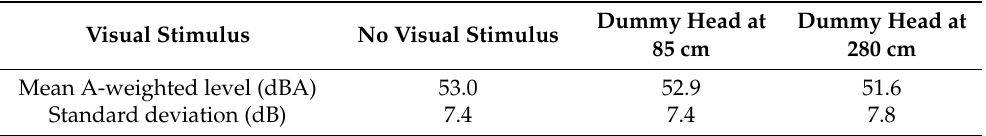
Table 5. Marginal means and standard deviations of the groups at three different levels of the visual stimulus in the listening part of the experiment.